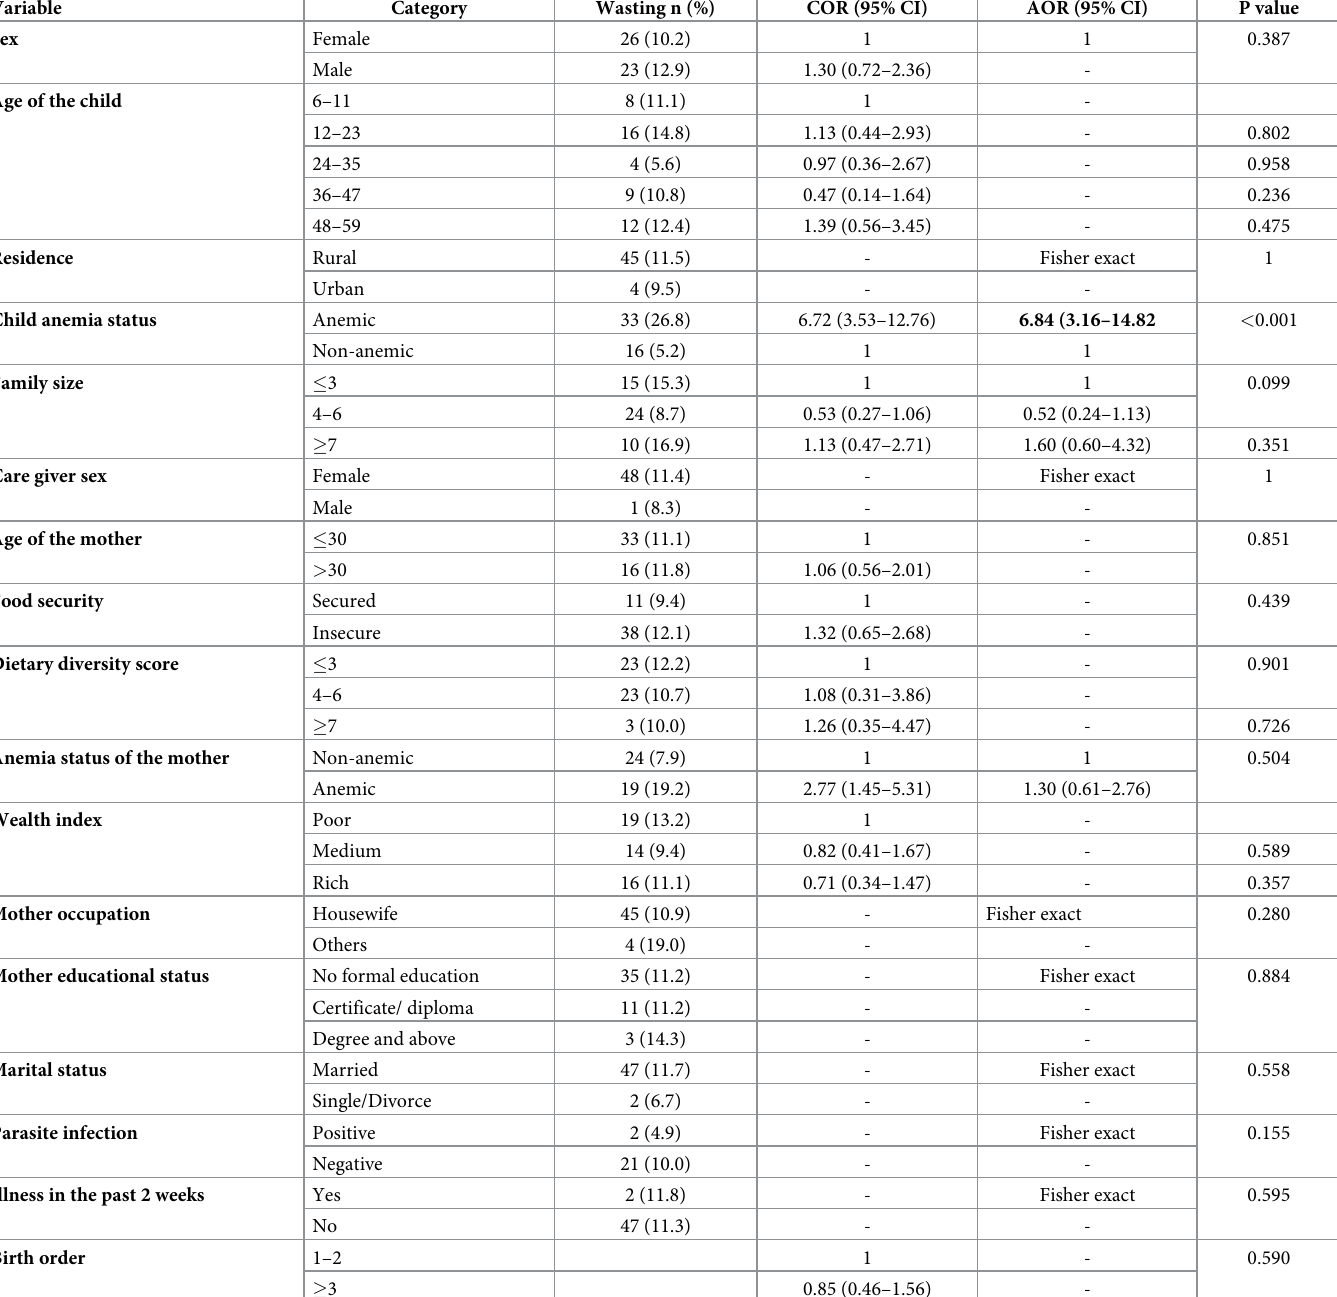
Table 4. Bivariable and multivariable logistic regression analysis of wasting among children aged 6 to 59 months in the Menz GeraMidir district Northeast Ethiopia in 2021, (N = 432). Variable